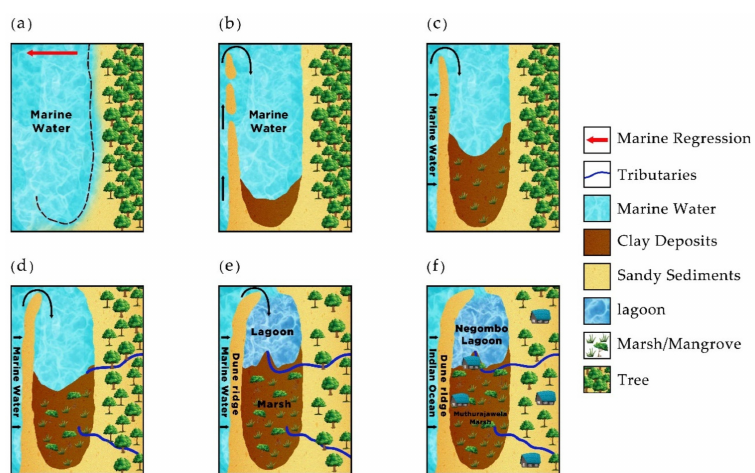
Figure 1. Geological evolution of the Muthurajawela Marsh and Negombo Lagoon (MMNL), Sri Lanka, from the Holocene period to the present. ( a ) The MMNL in the mid-Holocene period, marked with a marine regression, exposing a wider coastal area; ( b ) Wetland started to form (c. 7000); ( c ) Formation of wetland from south to north and clay deposits continued (c. 6500); ( d ) Marshland and lagoon started to form as an interdependent ecological system (c. 6500–6300); ( e ) Formation of marshland and lagoon continued at the final stage, forming one contiguous wetland (c. 6000); and ( f ) The present condition in which the MMNL is an important urban wetland ecosystem (UWE) in the Colombo Metropolitan Region with high socio-ecological significance. The images were sourced from the MMNL’s master plan and MMNL’s conservation management plan